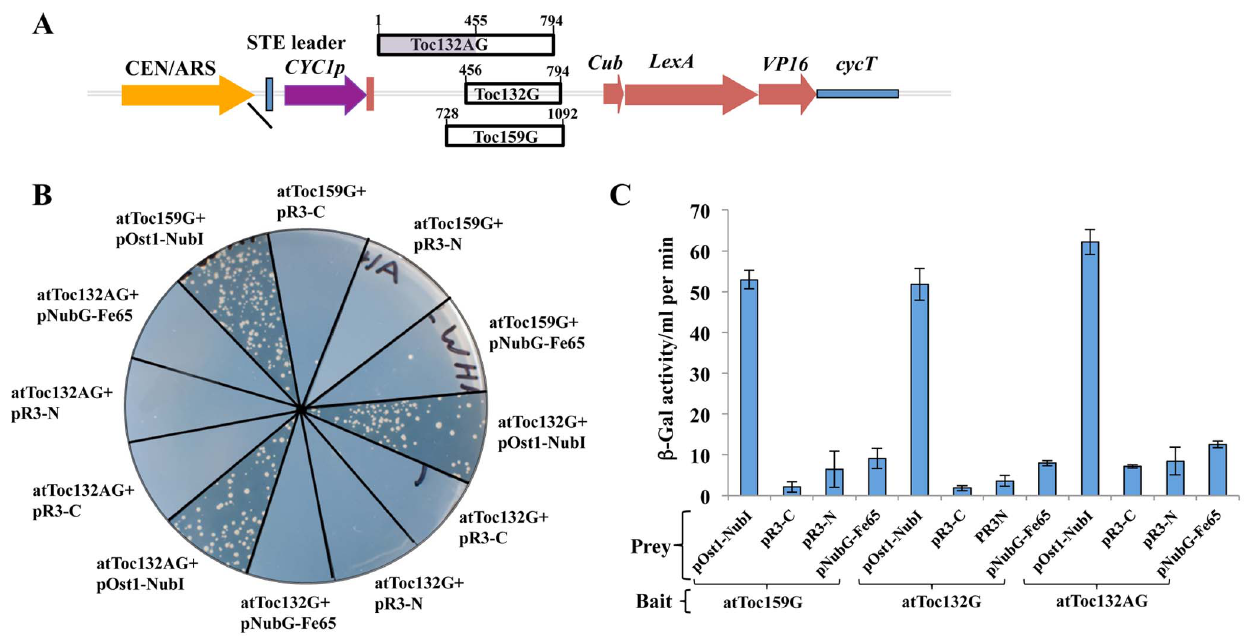
Figure 1. Analysis of yeast clones expressing the functional atToc159G, atToc132G and atToc132AG bait proteins. (A) Diagrammatic representation of the domain organisation of the atToc159G, atToc132G and atToc132AG bait constructs in the yeast plasmid, pBT3-STE. The bait vector provides an upstream yeast STE2 leader sequence and yeast ubiquitin Cub (34–76 aa), LexA and VP16 genes downstream. Fusion proteins produced by this cassette are expressed constitutively by the yeast CYC1 promoter and terminator. The bait protein domains were cloned directionally (using Sfi I) into the position indicated. The numbers refer to the amino acid sequence of atToc159 or atToc132. (B) The split-ubiquitin membrane based yeast two-hybrid analysis confirming expression of the bait proteins. atToc159G, atToc132G or atToc132AG bait was co-expressed in the S. cerevisiae strain NMY51 with the positive prey construct pOst1-NubI, empty prey vector, pR3-C/pR3-N or the non-interacting negative control construct pNubG-Fe65 and assayed on quadruple selective media (SD-LWHA) plates. Strains co-expressing bait protein and positive control prey exhibit growth only on SD-LWHA selective media. (C) Quantitative b -Galactosidase activity assay. Strains co-expressing respective bait and prey constructs were used in a microtitre plate-based b -galactosidase assay using 5-bromo-4-chloro-3-indolyl- b -D-galactopyranoside (X-Gal) as a substrate. The graph shows b -galactosidase activity/ml per min measured after 60 min. The values represent the mean of three independent experiments. The assay confirmed the functionality of the bait as the atToc159G, atToc132G and atToc132AG fusions interact with positive control prey but not with the empty vectors or negative control prey. photosynthetic function (Table 1) included an array of divergent proteins involved in various essential cellular processes such as i) early embryo development (Plastidial Dihydrolipoamide Acetyl- transferase and Glucose-6-phosphate transmembrane transporter), ii) biosynthetic pathways (Acyl Carrier Protein 2 ThiaminC, Rhomboid-Like Protein 11), iii) environmental stress signaling (VQ motif-containing protein), iv) seed development (Outer Plastid